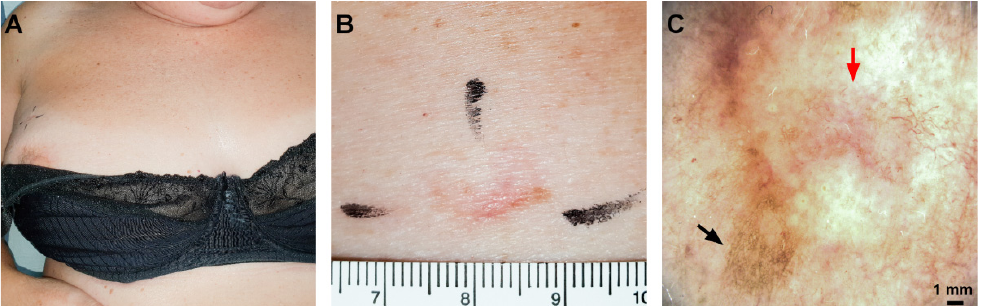
Figure 1. Clinical and dermoscopical aspect of the lesion. ( A ) Solitary, reddish lesion located on the right breast of a 66-year-old woman. ( B ) Close-up image of the lesion in panel A (measuring scale graded in centimeters)—asymmetrical lesion with ill-defined borders and peripheral brown pigmentation. ( C ) Dermoscopically, the lesion was characterized by the presence of a reddish areas, coalescing white patches, clusters of in-focus, short, truncated blood vessels and dotted vessels (red arrow), and a peripheral, brown reticulated pattern (black arrow). Table 1. RCM and histological features of multinucleate cell angiohistiocytoma and its mimickers. Lesion Type RCM Typical honeycomb pattern, with occa-